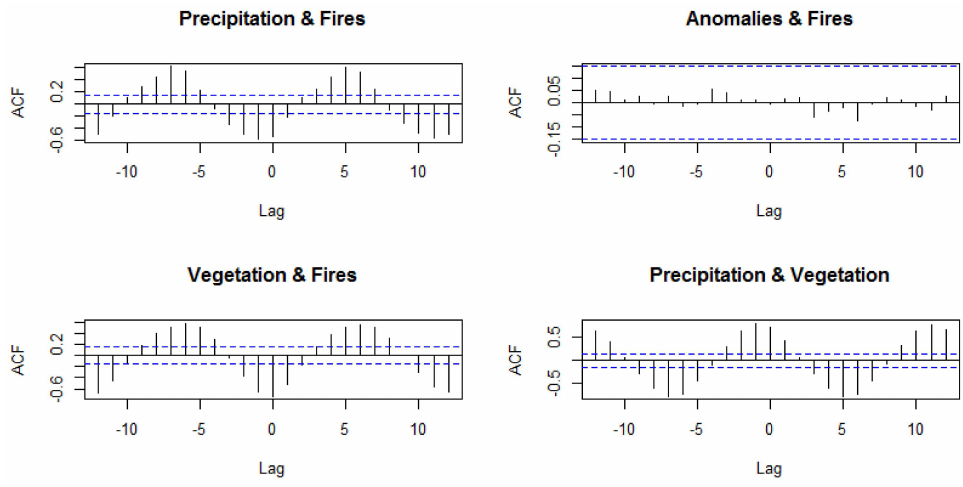
Figure 8. Cross correlation function (CCF) plots for El Salvador. Y -axis is the autocorrelation function (ACF), and the lag is shown on the X